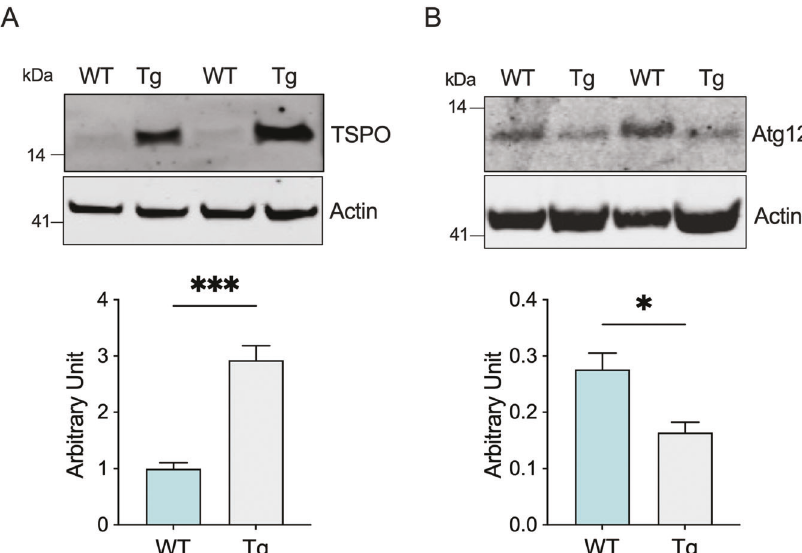
Fig. 4 Expression of TSPO and Atg12 are inversely correlated in transgenic mice. Western blot of proteins extracted from spinal cords of wild type and transgenic mice and the relative quantitative analysis of TSPO A and Atg12 B . Western blot quanti fi cations were performed by normalizing the protein of interest to Actin, here used as loading control. Data in histograms are expressed as mean ± SEM of n = 4 independent measurement and statistically analyzed by Student t-test, with * p < 0.05 and *** p <